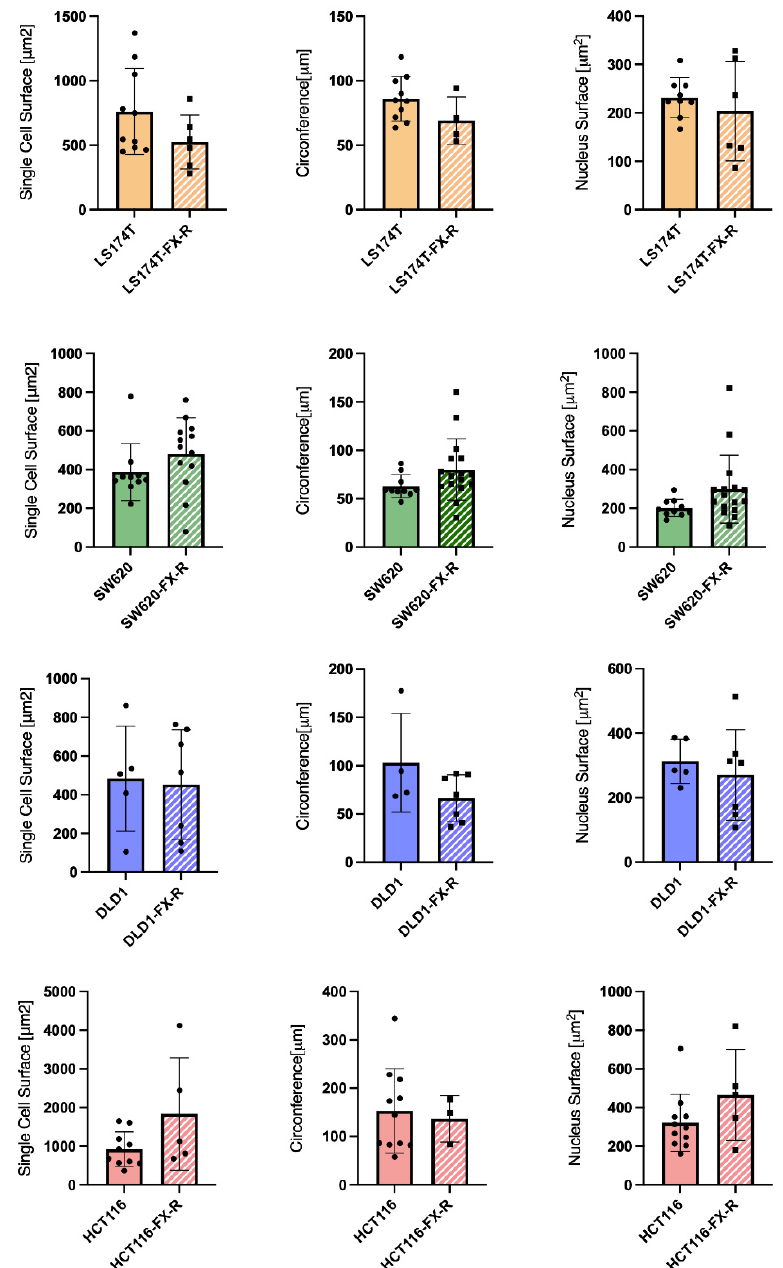
Figure 3. Cell morphology after FOLFOXIRI chronic treatment. Bar graphs of image-based quantifi- cation of single cell size (left graphs), circumference (middle graphs) and nucleus size (right graphs) of LS174T (yellow bars) SW620 (green bars) DLD1 (blue bars) and HCT116 (red bars) cells and their FX-R clones (N = 2, n = 5–10). Error bars represent the SD.